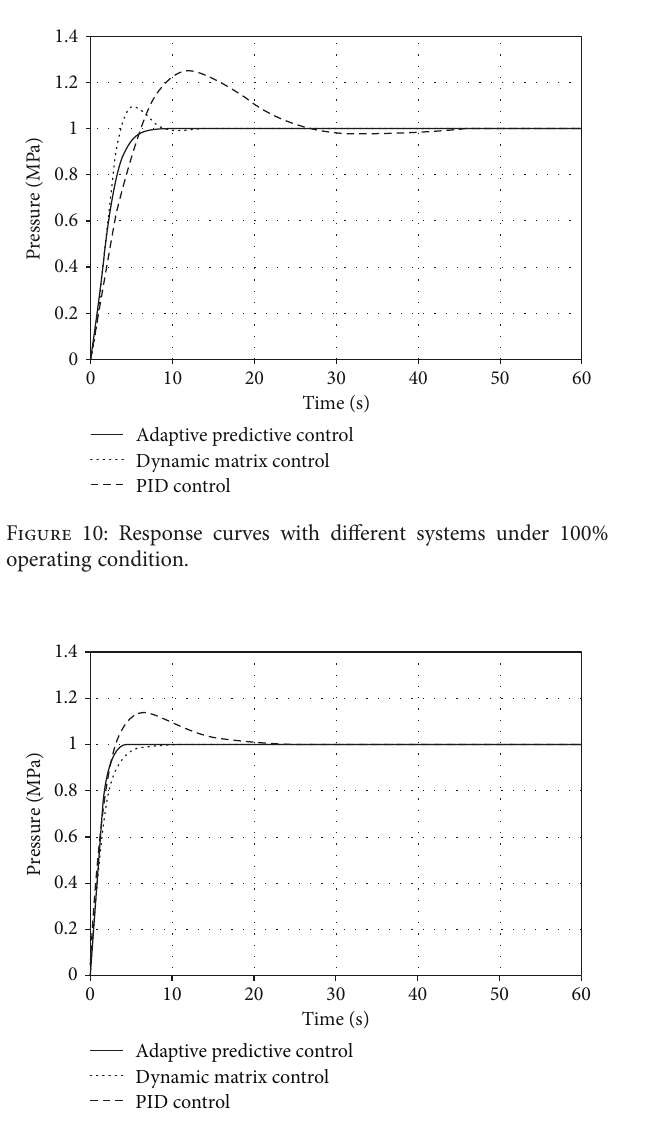
Figure 11: Response curves with di ff erent systems under 80% operating